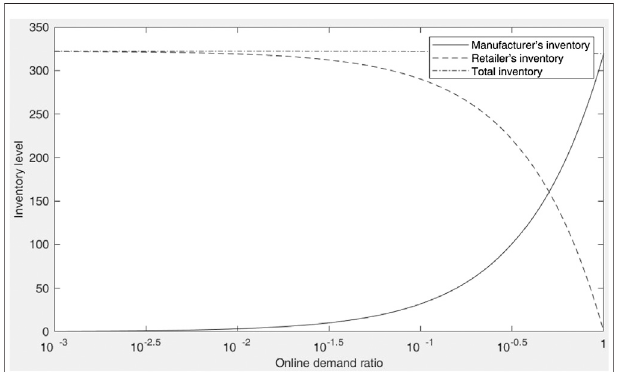
FIGURE 2 | Inventory trends.